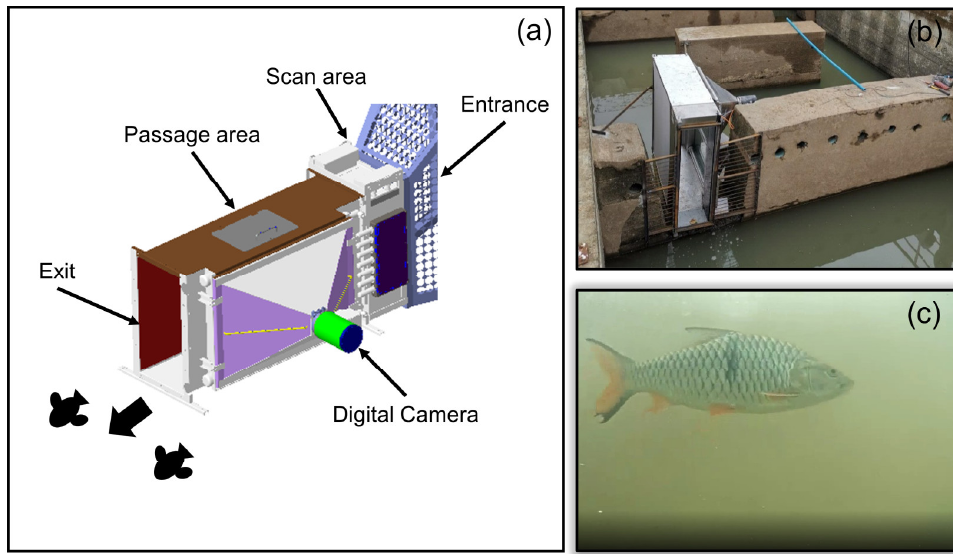
Figure 3. ( a ) Schematic diagram, ( b ) photographic representation, and ( c ) screenshot of the underwater video monitoring system.